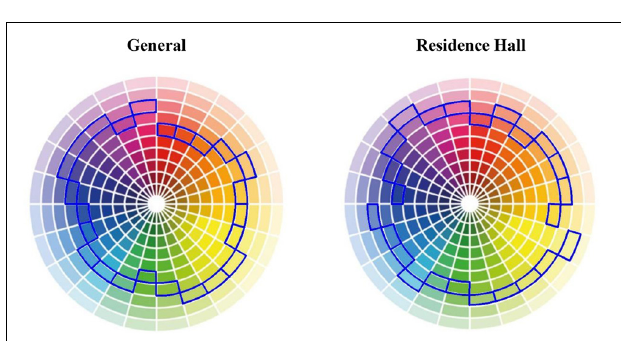
FIGURE 7 | Preferred lightness level (blue frame), for each of the 24 hues, in the general condition (left) and in the university residence hall condition (right)